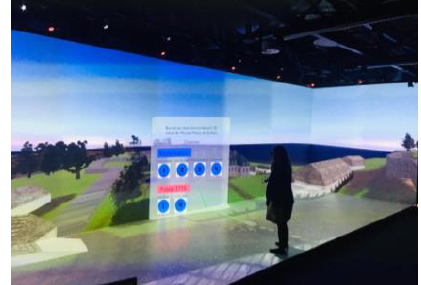
Figure 2. Test of the 3D model of the Intendance’s palace in an immersive